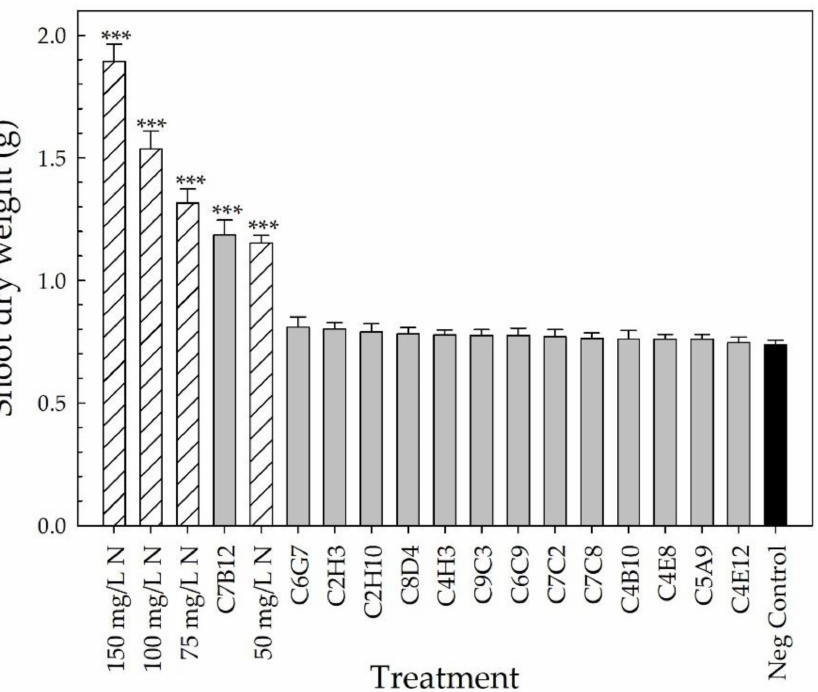
Figure 7. Shoot dry weight (DW) (g) was measured in the greenhouse validation trial of Petu- nia × hybrida ‘Picobella Blue’ treated with the 14 bacterial strains selected from the high-throughput greenhouse trials ( n = 12). Shoots were harvested 4 weeks after transplant and dried in a forced air oven (49 ◦ C). All plants treated with bacteria were fertilized with 25 mg L − 1 N (gray bars). The black bar represents the negative control (no bacterial treatment) fertilized with 25 mg L − 1 N, and the white bars with slanted lines represent the four positive controls (no bacterial treatment) fertilized with either 50, 75, 100, or 150 mg L − 1 N. The treatments were compared to the negative control using Dunnett’s comparison. Significance is represented by *** at p ≤ 0.001. Bars represent the mean, and error bars denote standard